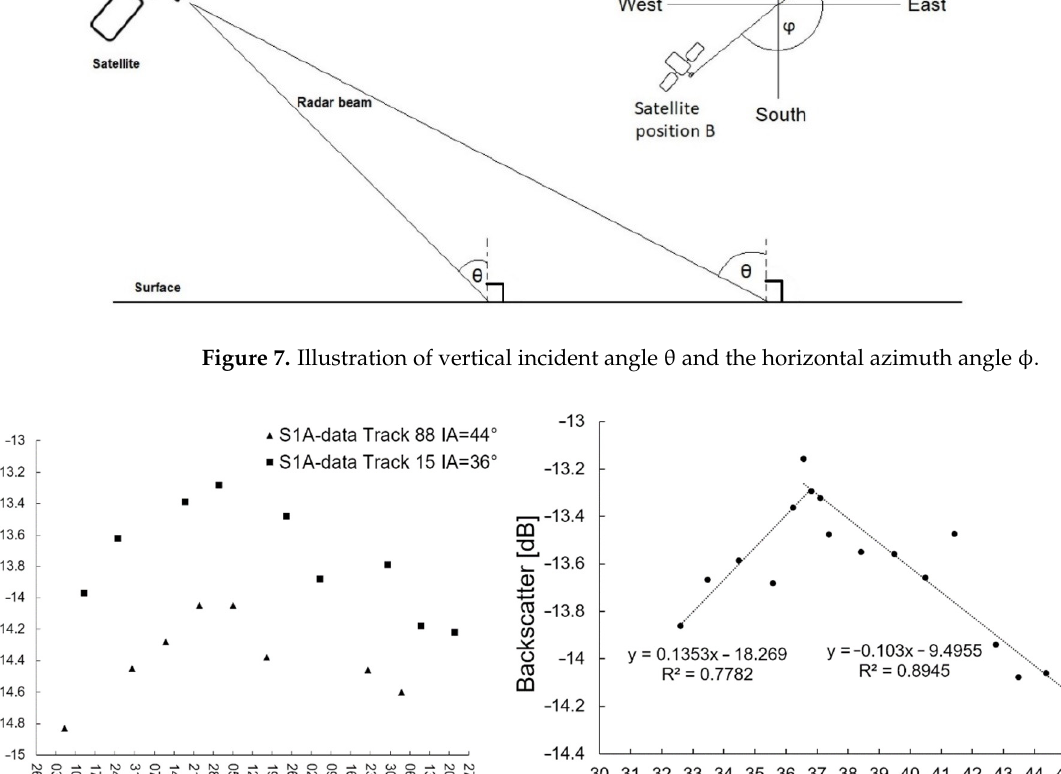
Figure 7. Illustration of vertical incident angle θ and the horizontal azimuth angle ϕ .